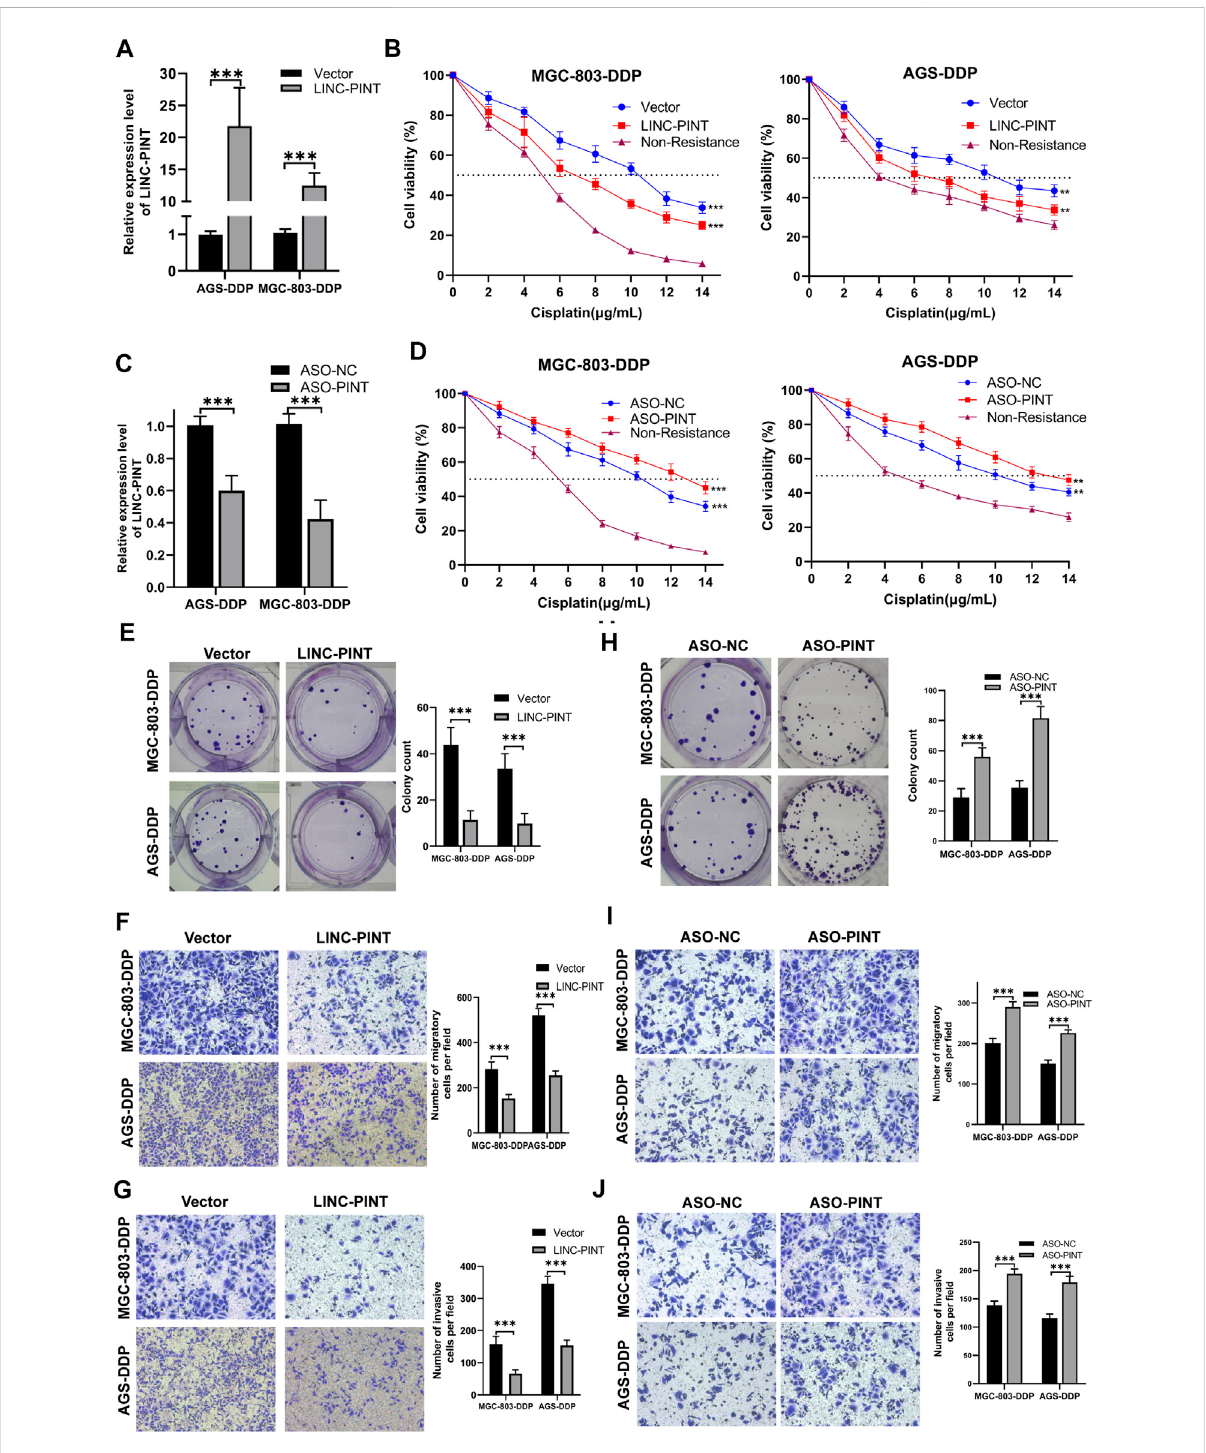
FIGURE 2 LINC-PINT involvement in DDP-resistance in GC. (A) LINC-PINT expression in LINC-PINT-overexpressing AGS-DDP and MGC-803-DDP cells. (B) CCK-8 assays in LINC-P INT-overexpressing AGS-DDP and MGC-803-DDP cells. (C) LINC-PINT expression in LINC-PINT-silenced AGS-DDP and MGC- 803-DDP cells. (D) CCK-8 assays in LINC-PINT-silenced AGS-DDP and MGC-803-DDP cells. (E) Colony formation assay of LINC-PINT-overexpressing AGS-DDPandMGC-803-DDPcells. (F) TranswellassaysevaluatingthemigrationabilityofLINC-PINT-overexpressingAGS-DDPandMGC-803-DDP cells. (G) Transwell assays evaluating the invasion ability of LINC-PINT-overexpressing AGS-DDP and MGC-803-DDP cells. (H) Colony formation assay of LINC-PINT-silenced AGS-DDP and MGC-803-DDP cells. (I) Transwell assays evaluating the migration ability of LINC-PINT - silenced AGS-DDP and